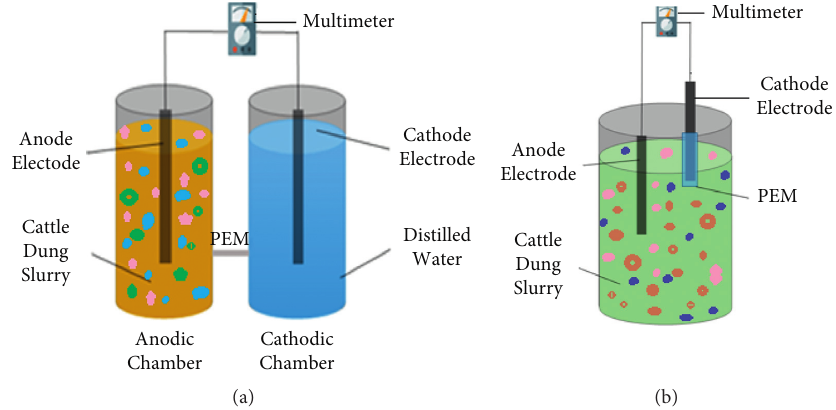
Figure 3: (a) Double-chamber MFC. (b) Single-chamber